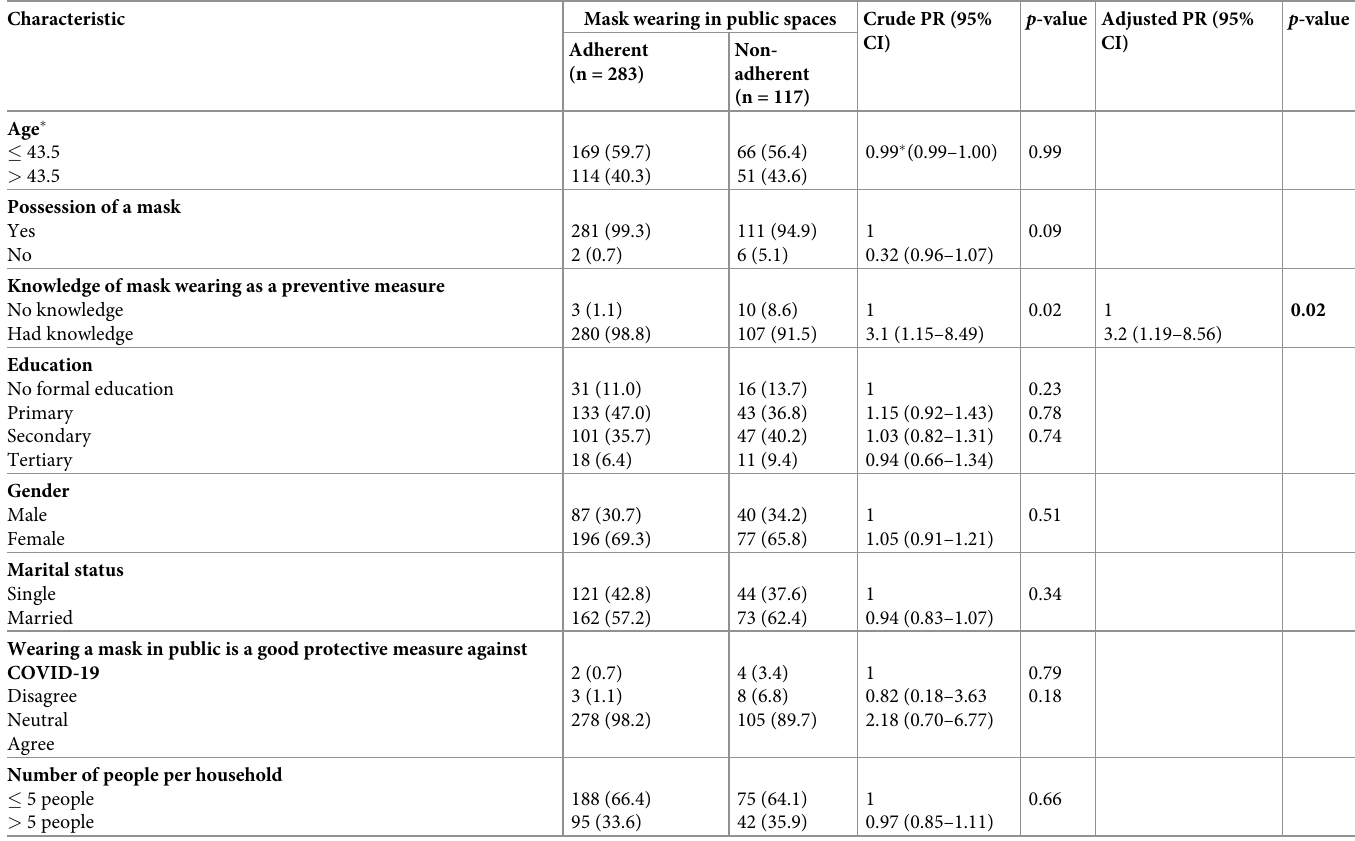
Table 5. Predictors of mask